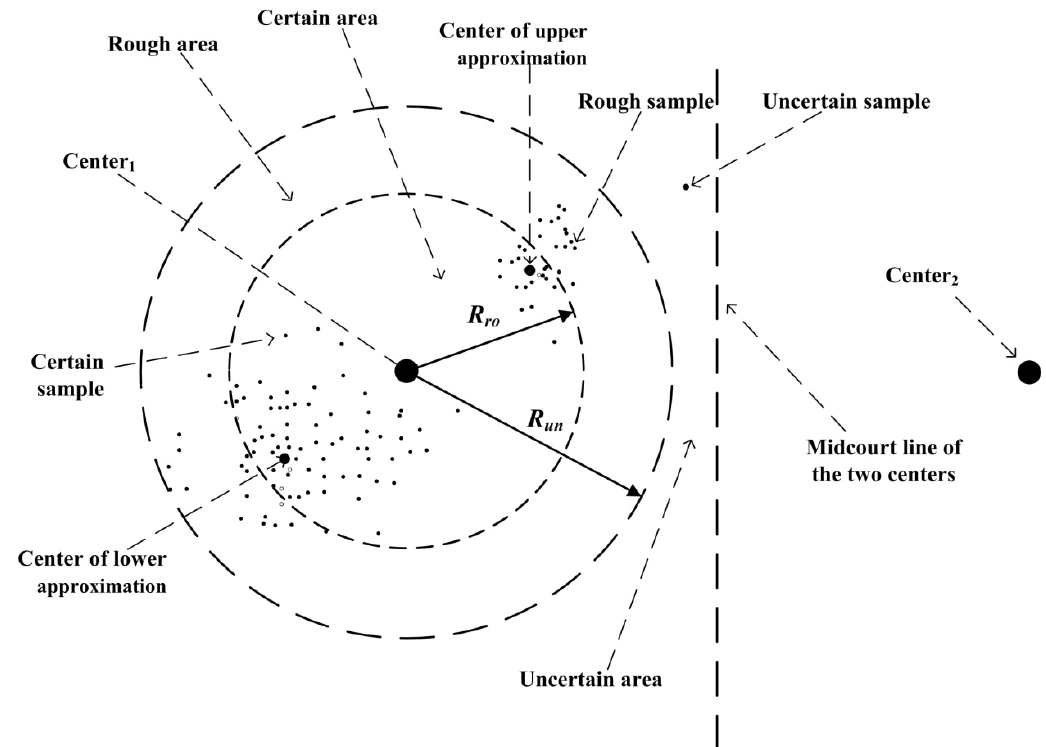
Figure 1. Regions of the rough k -means classifier: the certain, the rough and the uncertain area. Linearly separable samples are usually near to the center, while linearly inseparable samples are usually far from the